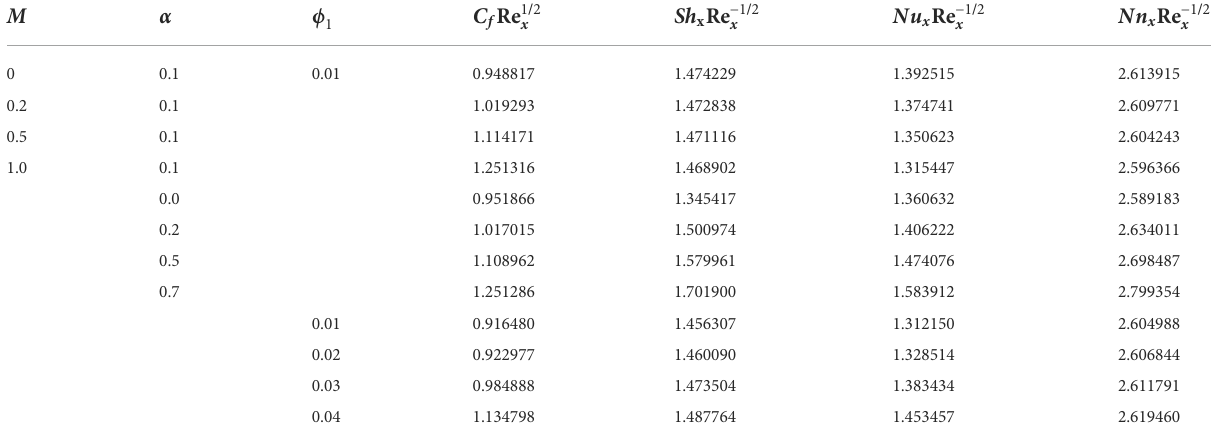
TABLE 3 Numerical outcomes of C f Re 1/2 x , Sh x Re − 1/2 x , Nu x Re − 1/2 x , and Nn x Re − 1/2 x when β → ∞ .